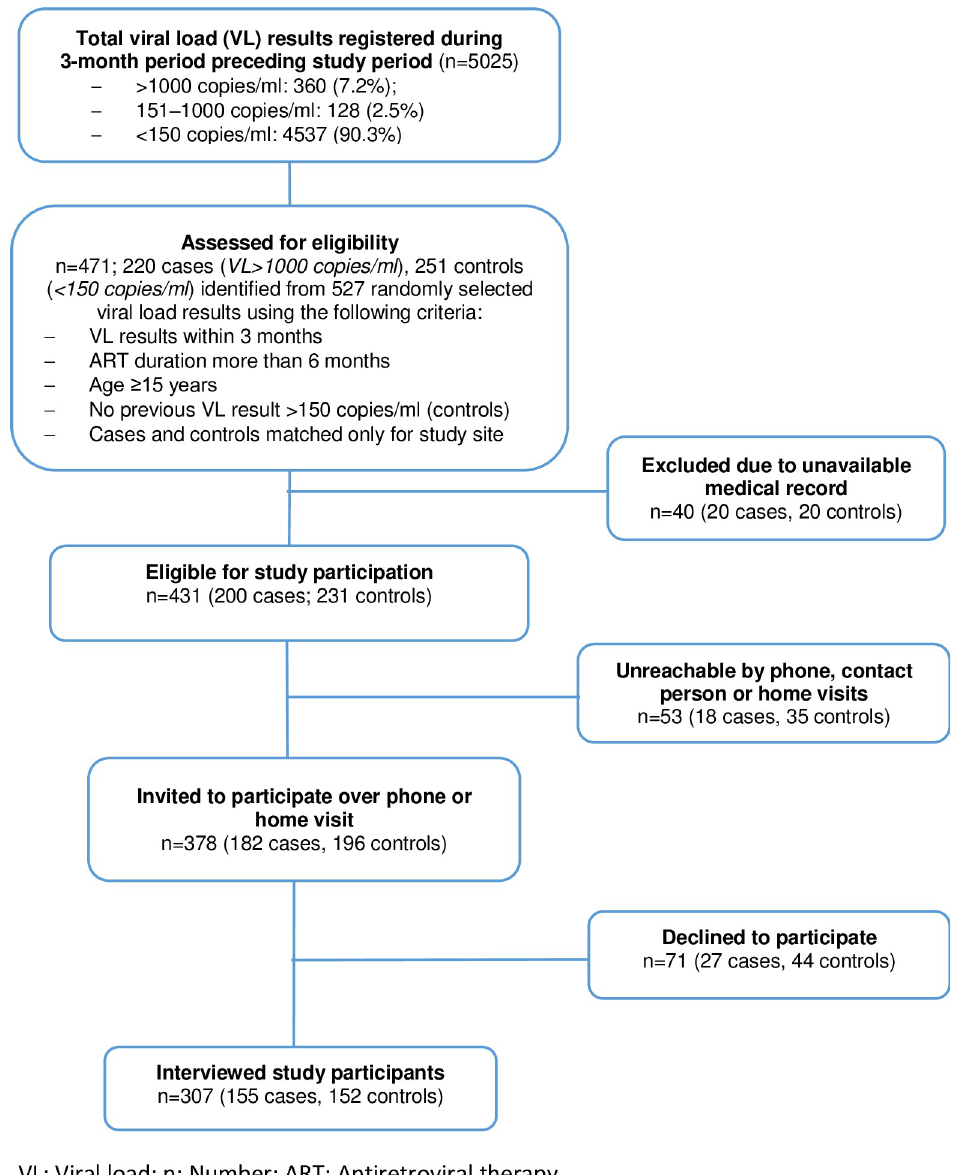
Fig 1. Flowchart of study participant